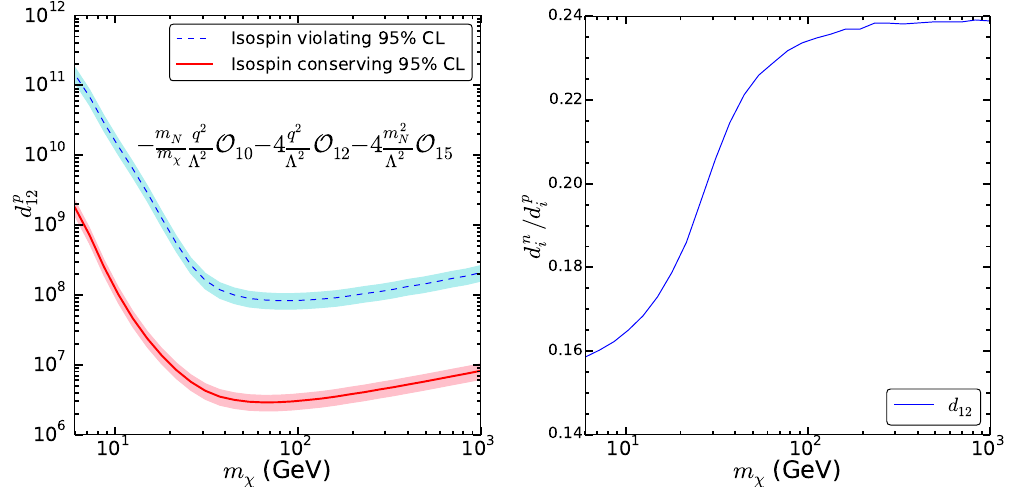
to c p for the other 13 operators except O 13 . i i